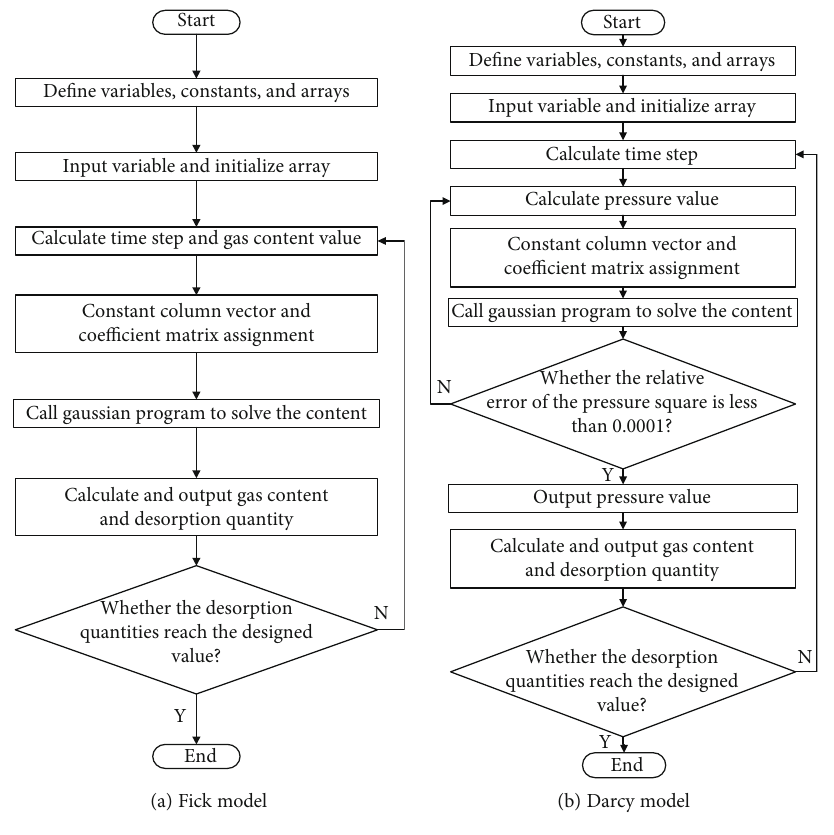
Figure 5: Flowchart of program